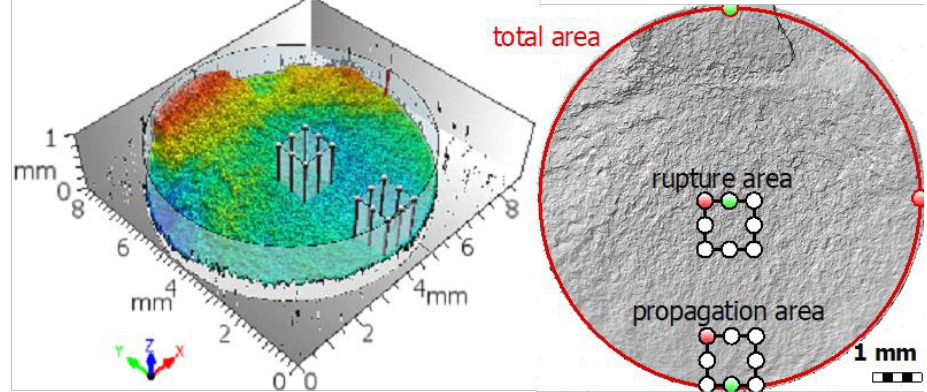
Figure 4. Extracting methodology used to fit the region of interest (ROI).